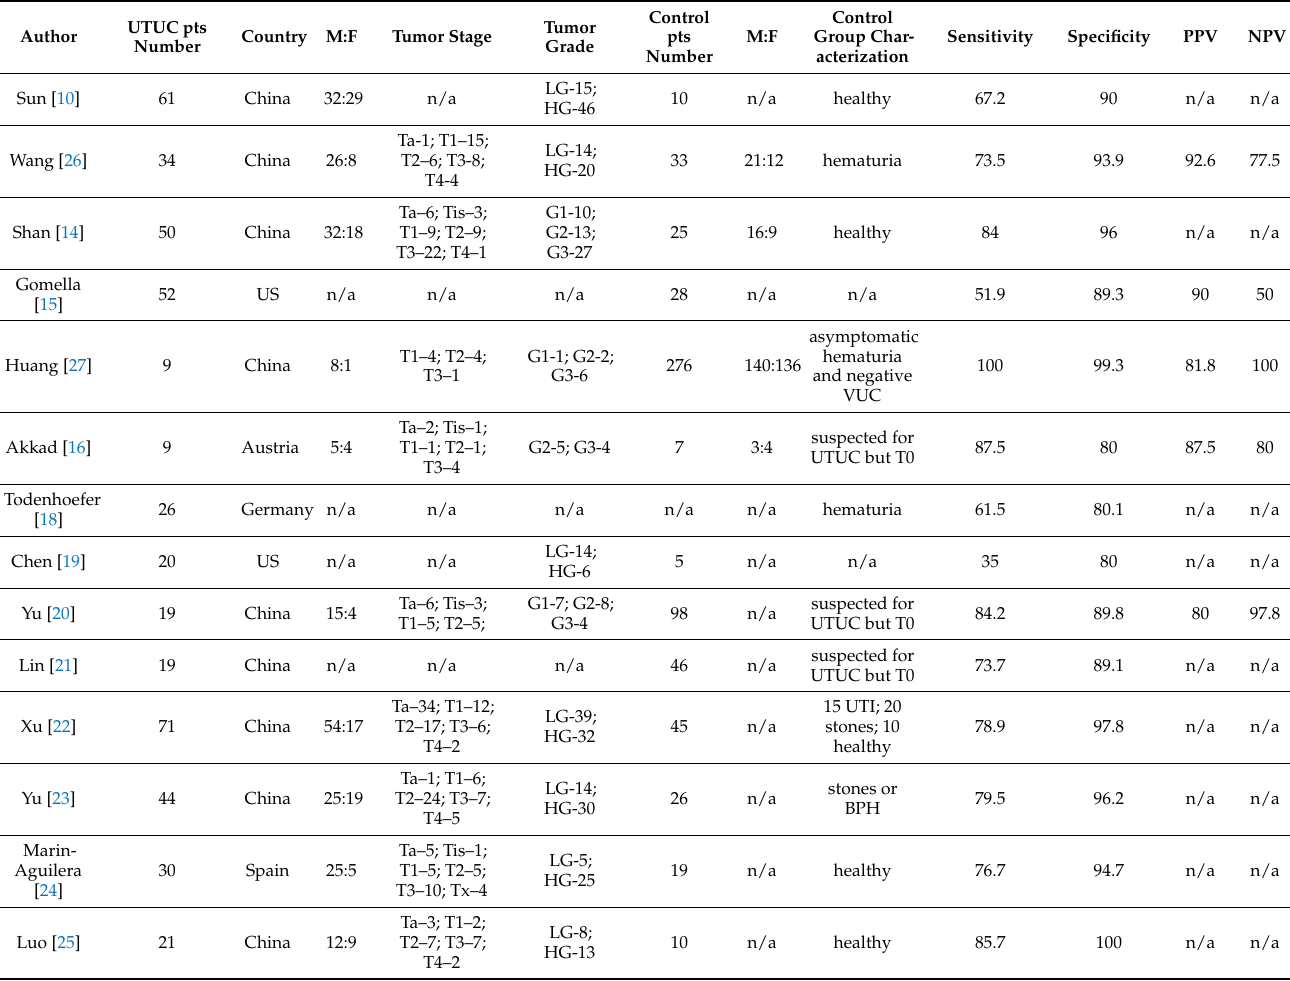
Table 2. The performance of FISH in the diagnosis of